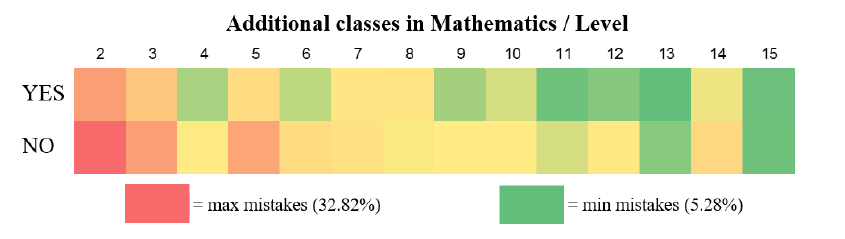
Fig. 3. Difficulty of game levels differentiated by whether students take additional classes in Mathematics in the game “Zagonetke mudrog